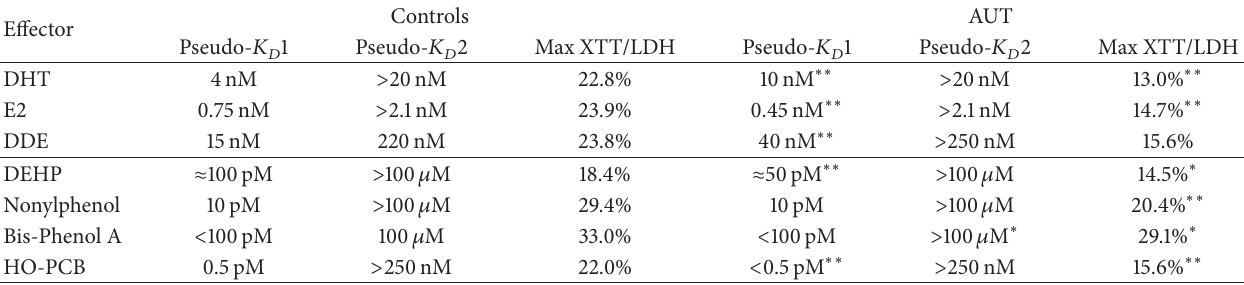
Table 4: Summary of differential hormone/hormone disruptor effects on B-cell